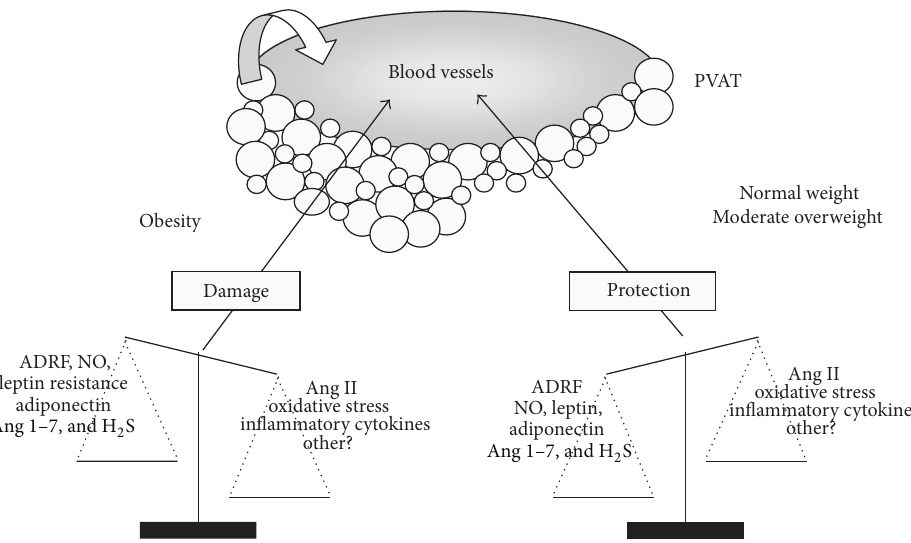
Figure 2: Hypothesis of the role of PVAT and PVAT-derived adipokines in health and